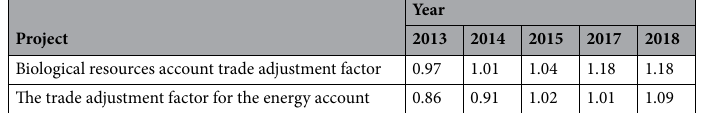
Table 1. Trade adjustment coefficients of Guangdong Province from 2013 to